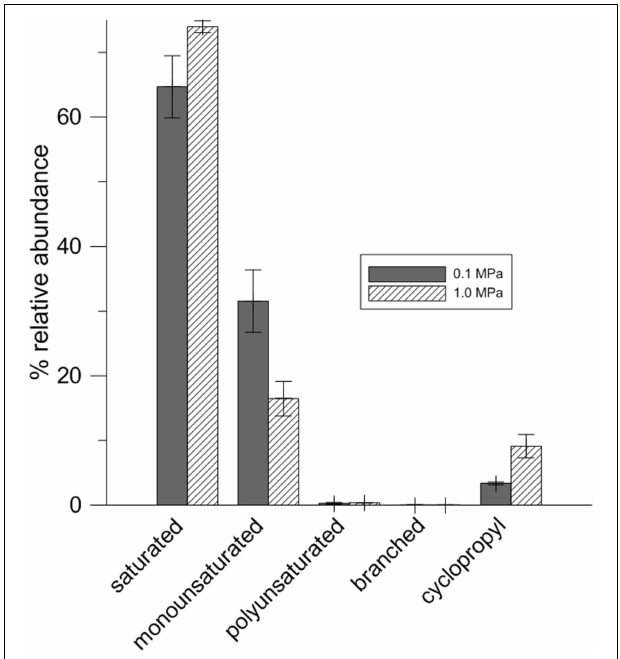
FIGURE 4 | CG-1 fatty acid compositions at 0.1 and 1.0MPa CO 2 .